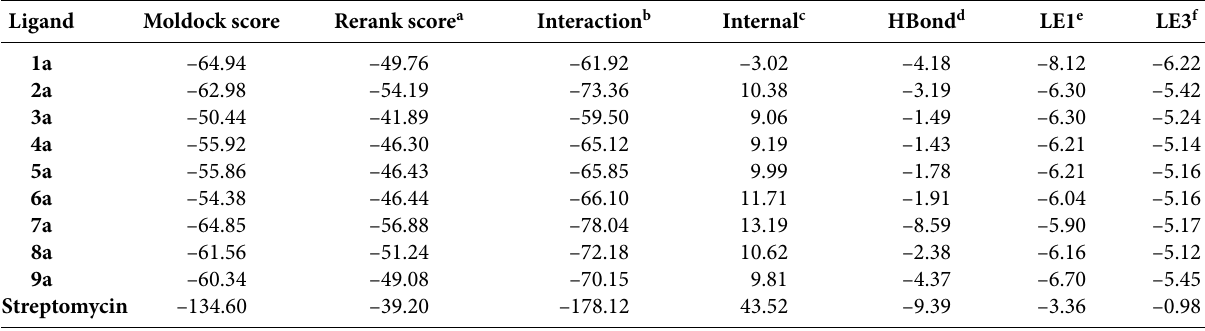
Table 5. Docking score of the compounds with 3SRW